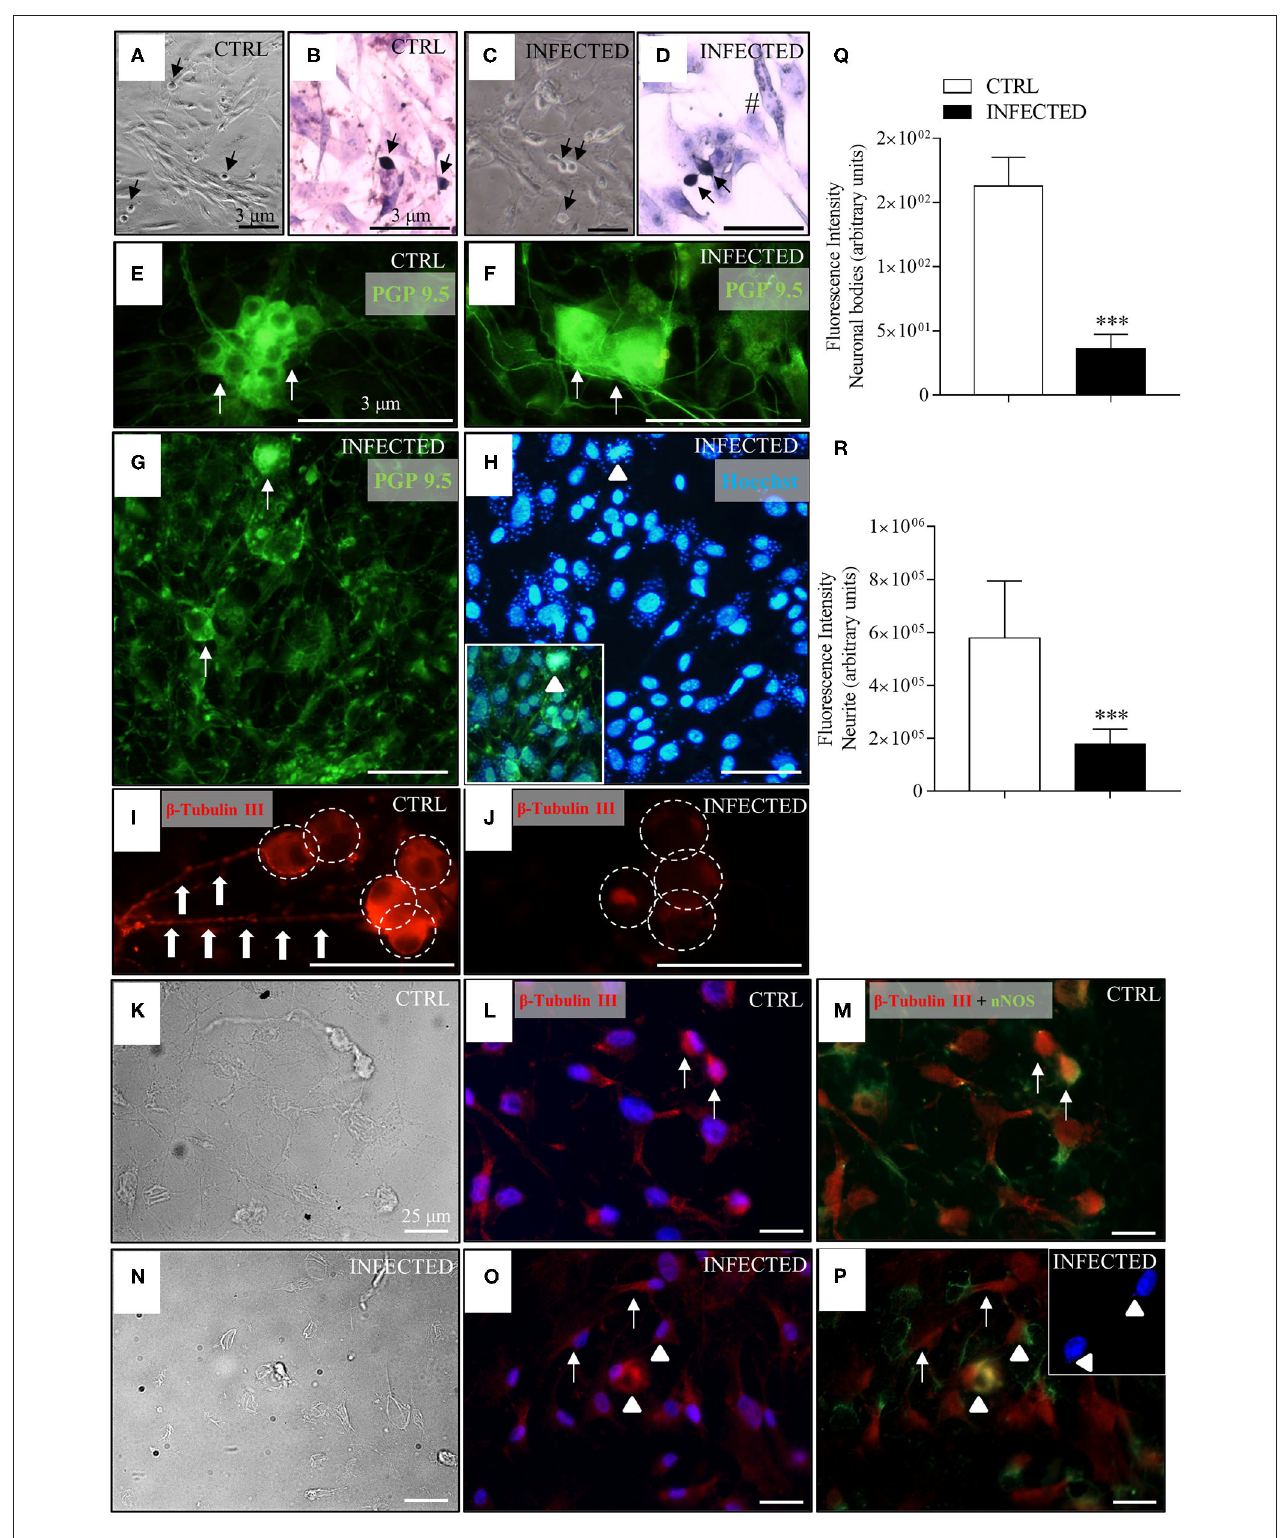
FIGURE 4 | Effect of T. cruzi infection of enteric neuron cultures on neuronal bodies and neurite network. Neurons removed from the myenteric plexus were dissociated, plated, and infected or not with trypomastigotes of the T. cruzi strains Y and Dm28c. Cultures were analyzed at 24, 48, and 72h post-infection